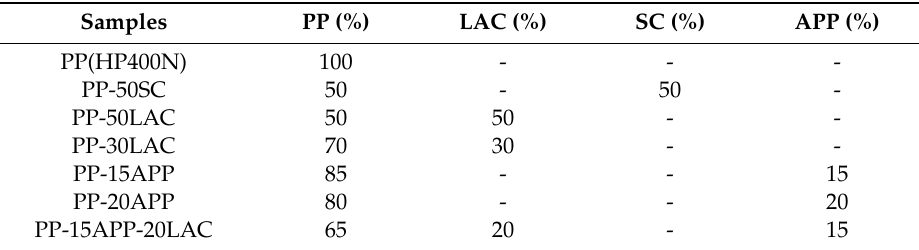
Table 1. The composition of all polypropylene (PP) composite